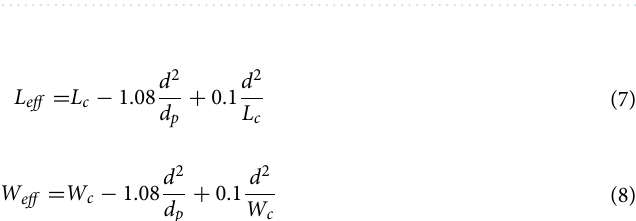
Table 1. The optimum values of unit cell